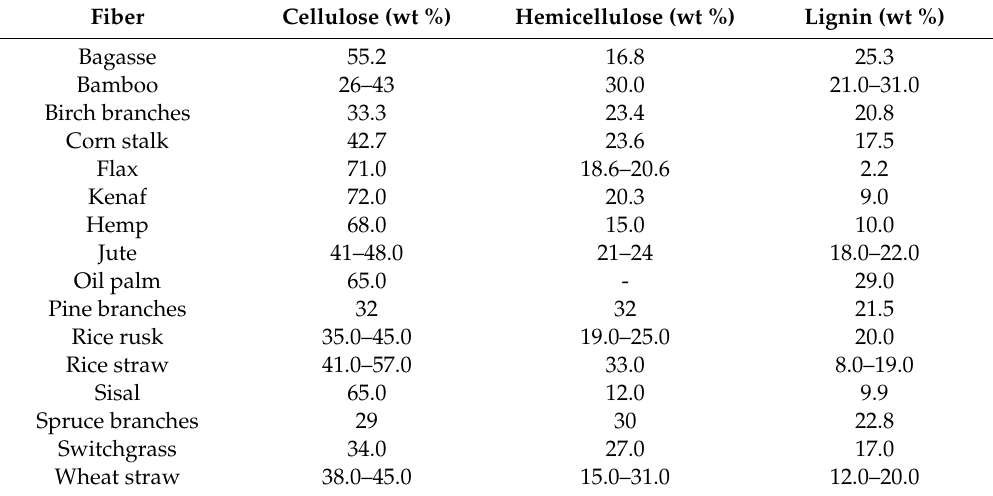
Table 1. Chemical composition of some lignocellulosic fibers [38–41].